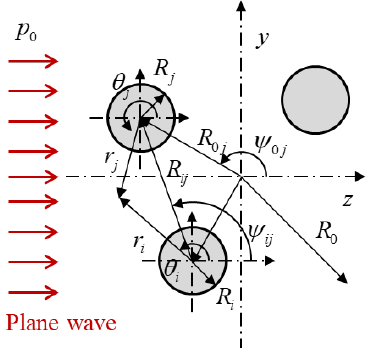
Figure 3. Definition diagram, coordinate systems and symbols used in the determination of the streamline and pressure of the surrounding fluid of the